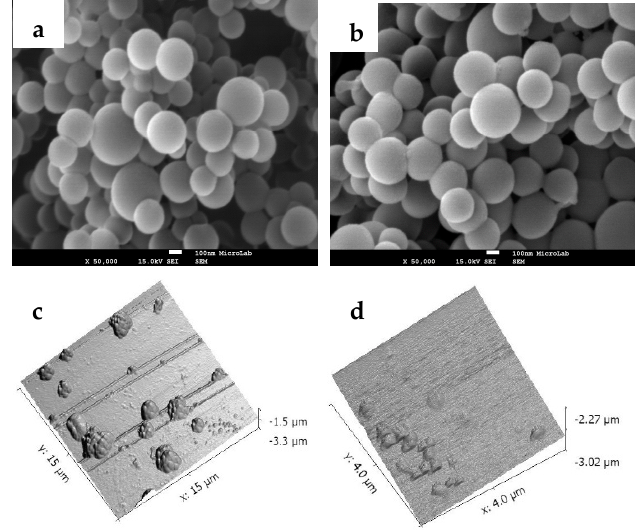
Figure 4. SEM: ( a ) PLGA NP, ( b ) PLGA-di-GAL NP (amplification of 50,000) and AFM: ( c ) clusters of PLGA-di-GAL NP, and ( d ) dispersed PLGA-di-GAL NP.